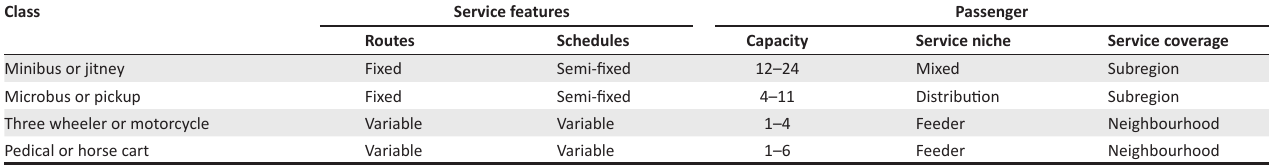
TABLE 1: Classes of paratransit vehicles and services that operate informally.